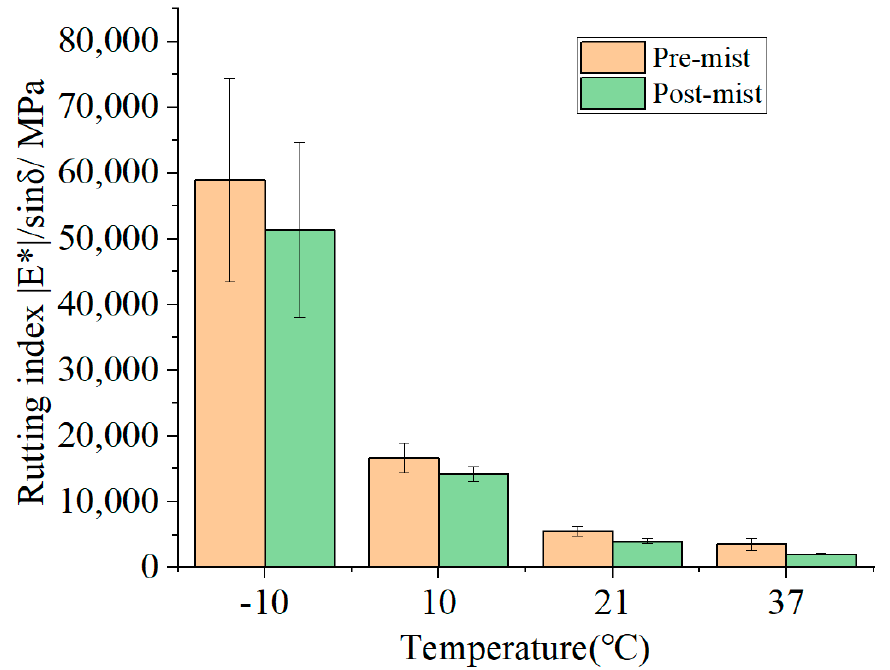
Figure 9. Rutting index at 10 Hz of pre-mist and post-mist CIR asphalt mixture. The moisture susceptibility of the pre-mist and post-mist CIR mixture was evaluated by the dynamic modulus ratio. For CIR, this was defined by the ratio of the dynamic modulus of pre-mist CIR mixture to that of the post-mist CIR mixture. The results of